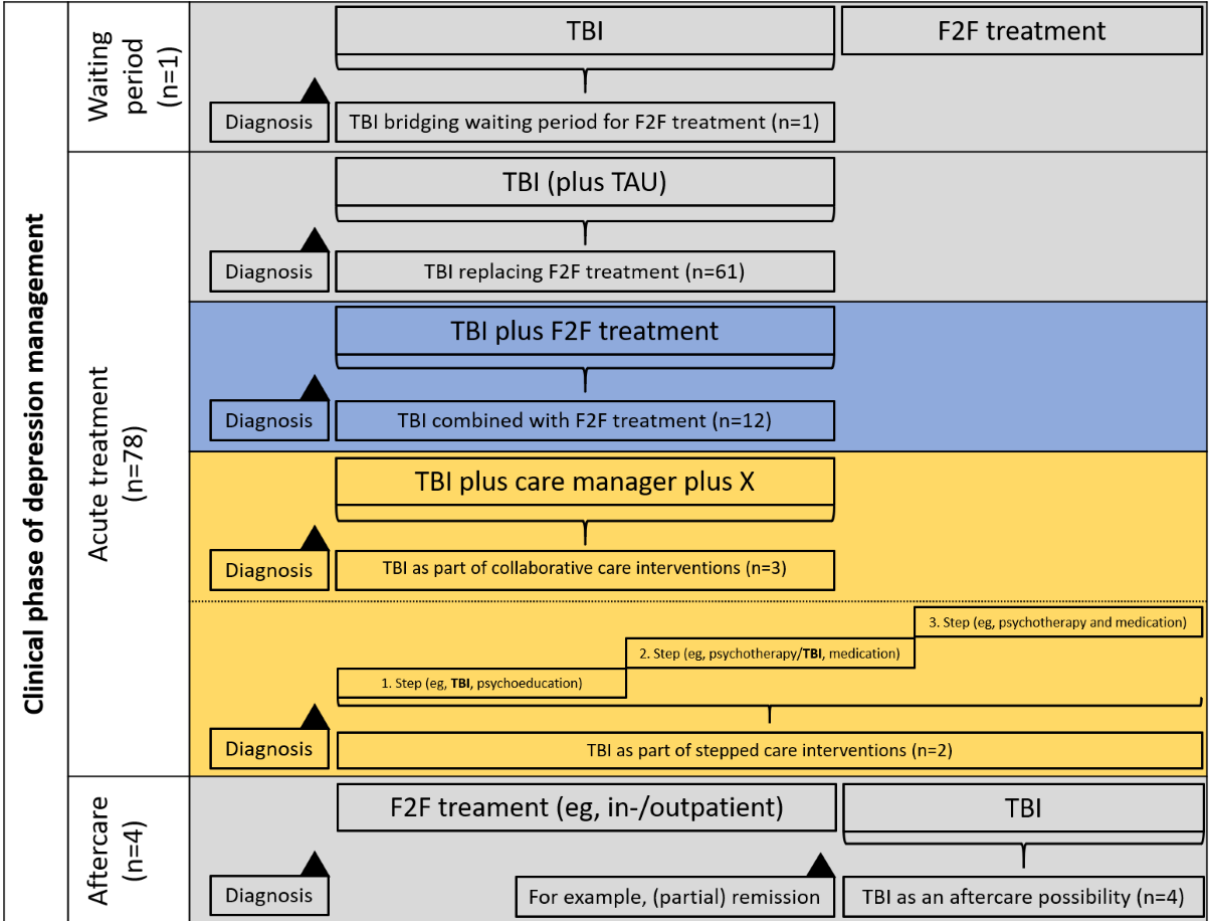
Figure 2. Distribution of studies (N=83) on application areas. Color highlighting of cells indicates format of implementation of TBIs: grey = (enhanced) stand-alone intervention; blue = blended treatment approach; yellow = TBI as part of collaborative/stepped care interventions. TAU: treatment as usual; TBI: technology-based psychological intervention; F2F: